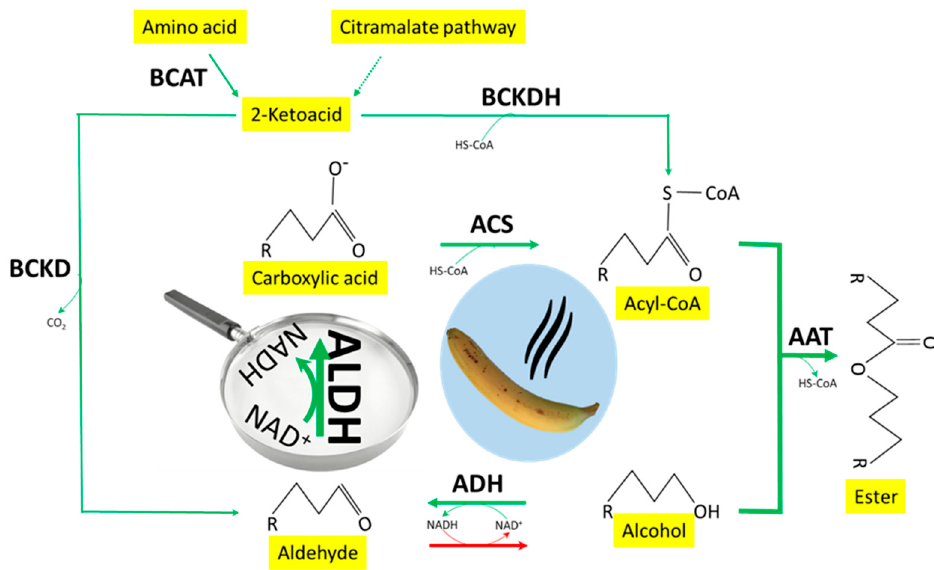
Figure 1. Role of aldehyde dehydrogenase (ALDH) in the dehydrogenation from aldehydes to car- boxylic acids and the entire ester production pathways. ADH, alcohol dehydrogenase; ACS, acyl- CoA synthetase; AAT, alcohol acyl-CoA transferase; BCAT, branched-chain amino transferase; BCKD, branched-chain α -ketoacid decarboxylase; BCKDH, branched-chain α -ketoacid dehydro-